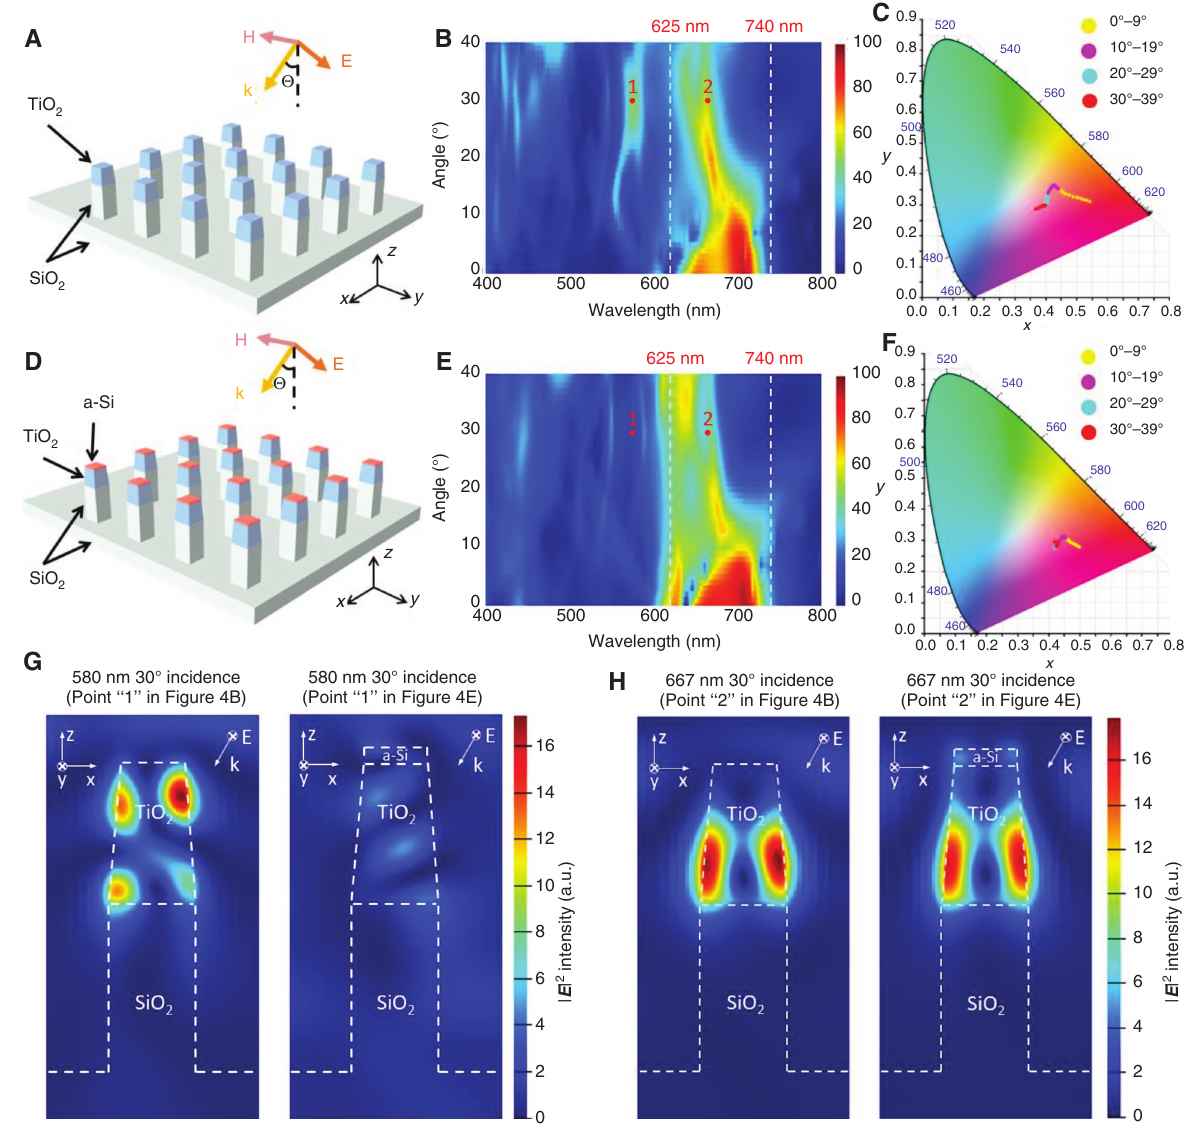
Figure 5: Resonant mode engineering. (A) Schematic of the all-dielectric metasurface at oblique incidence. (B) Calculated reflection spectra of the all-dielectric metasurface (A) versus the incident angle. (C) The numerically calculated color of the all-dielectric metasurface (A) versus the incident angle shown in a CIE 1931 color map. (D) Schematic of the all-dielectric metasurface with an a-Si cap at oblique incidence. The thickness of the a-Si cap is 40 nm. (E) Calculated reflection spectra of the all-dielectric metasurface with an a-Si cap (D) versus the incident angle. (F) The numerically calculated color of the all-dielectric metasurface with an a-Si cap (D) versus the incident angle shown in a CIE 1931 color map. (G) | E | 2 distributions of the all-dielectric metasurface with (A) and without (D) an a-Si cap upon 30 ° incidence at 580 nm. The left and right field distributions correspond to the point “1” in (B and E), respectively. (H) | E | 2 distributions of the all-dielectric metasurface with (A)/without (D) an a-Si cap upon 30 ° incidence at 667 nm. The left and right field distributions correspond to the point “2” in (B and E),